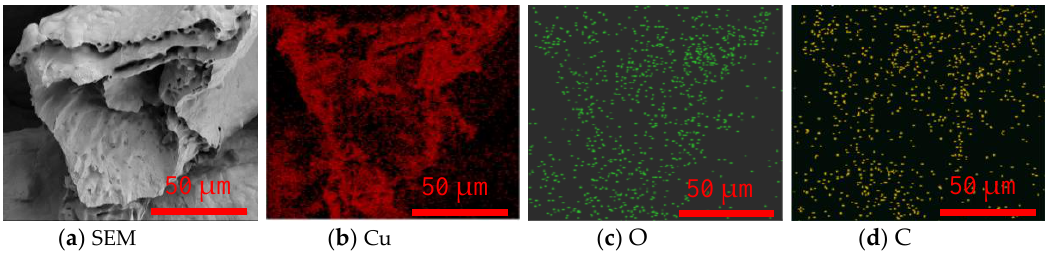
Figure 3. The cross-section SEM images of the OCMF substrates ( a ) with the corresponding elemental distribution maps for Cu ( b ), O ( c ) and C ( d ).